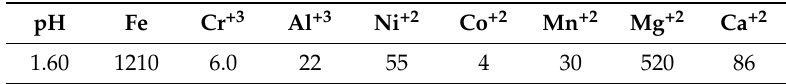
Table 5. Composition of wash water (mg/L) obtained after washing of the leach solid residue (step 1c in Figure